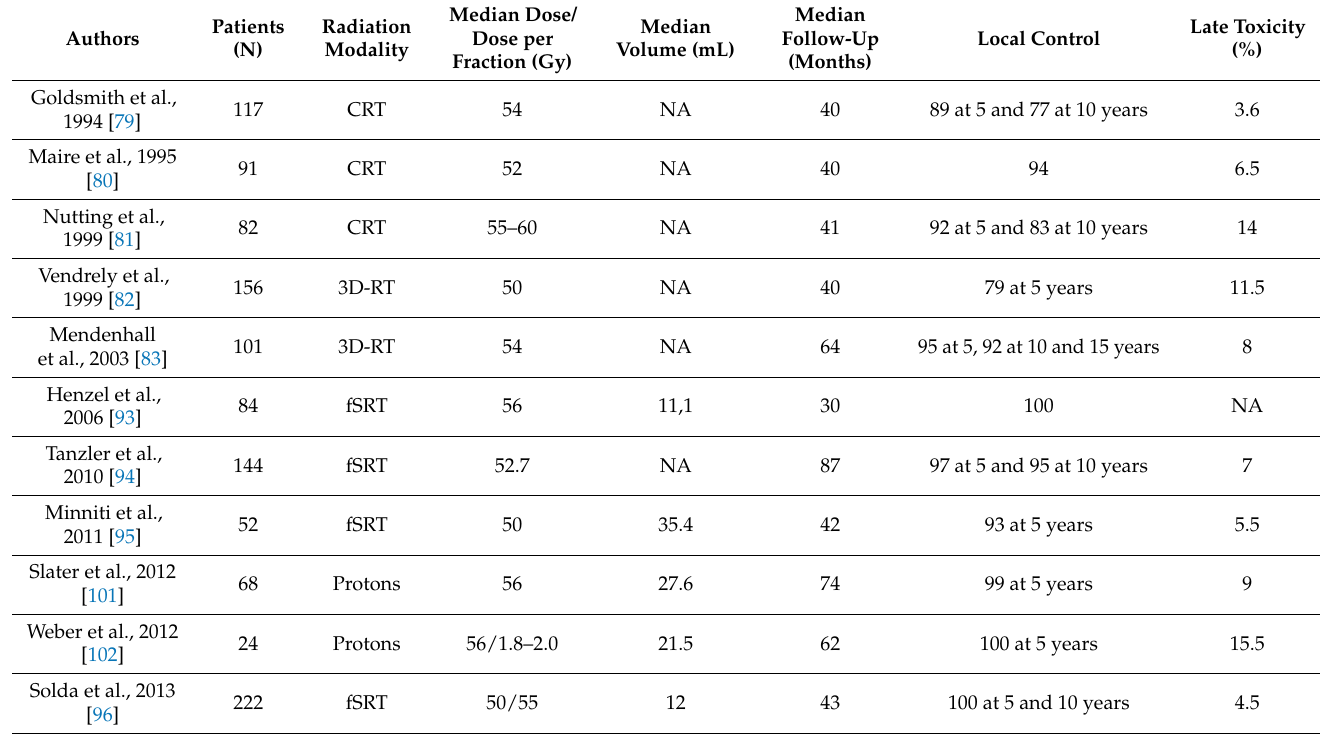
Table 3. Summary of selected published studies on conventionally fractionated radiotherapy for benign SBMs.